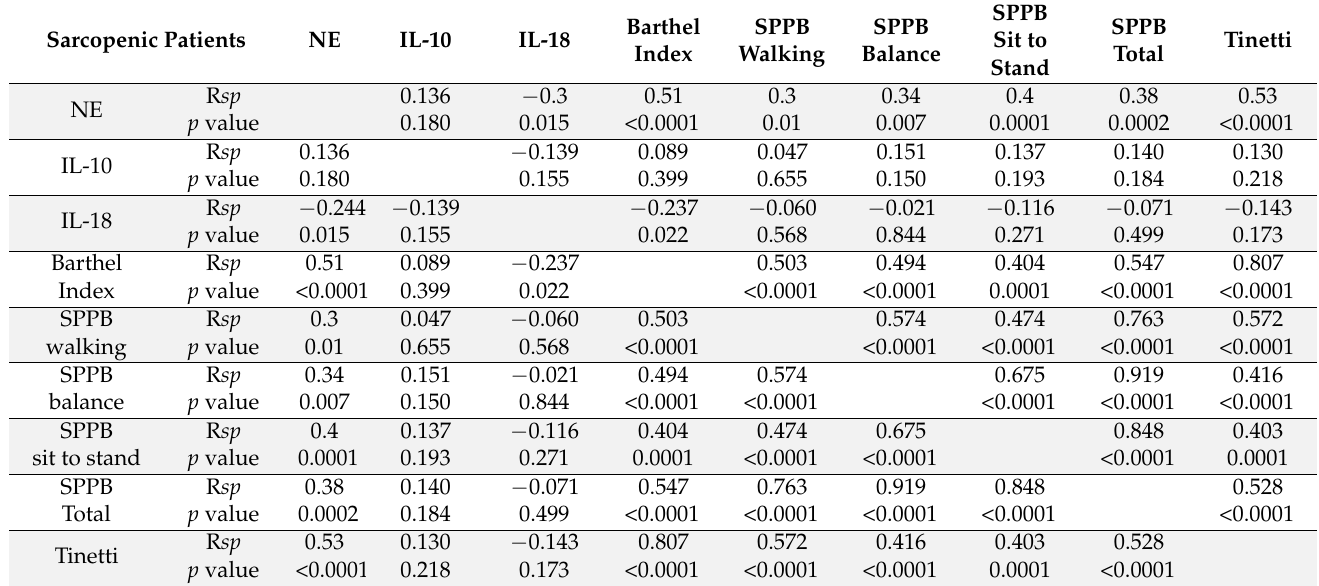
Table 2. Correlation table. R sp -values and p -values for the correlation analysis between clinical measures (Barthel Index, SPPB tests, and Tinetti test) and laboratory measures (norepinephrine, IL-10, and IL-18). Significant correlations are indicated in bold ( p value ≤ 0.05 and R sp ≥